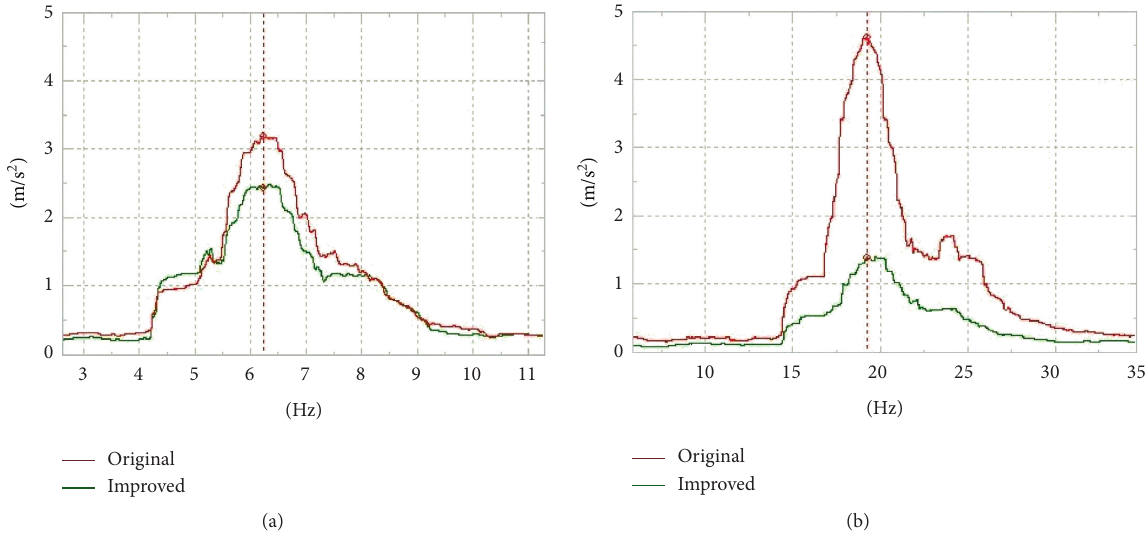
Figure 16: Spectrum of vibration acceleration of driver’s seat when driving speed reached (a) 35 km/h and (b)